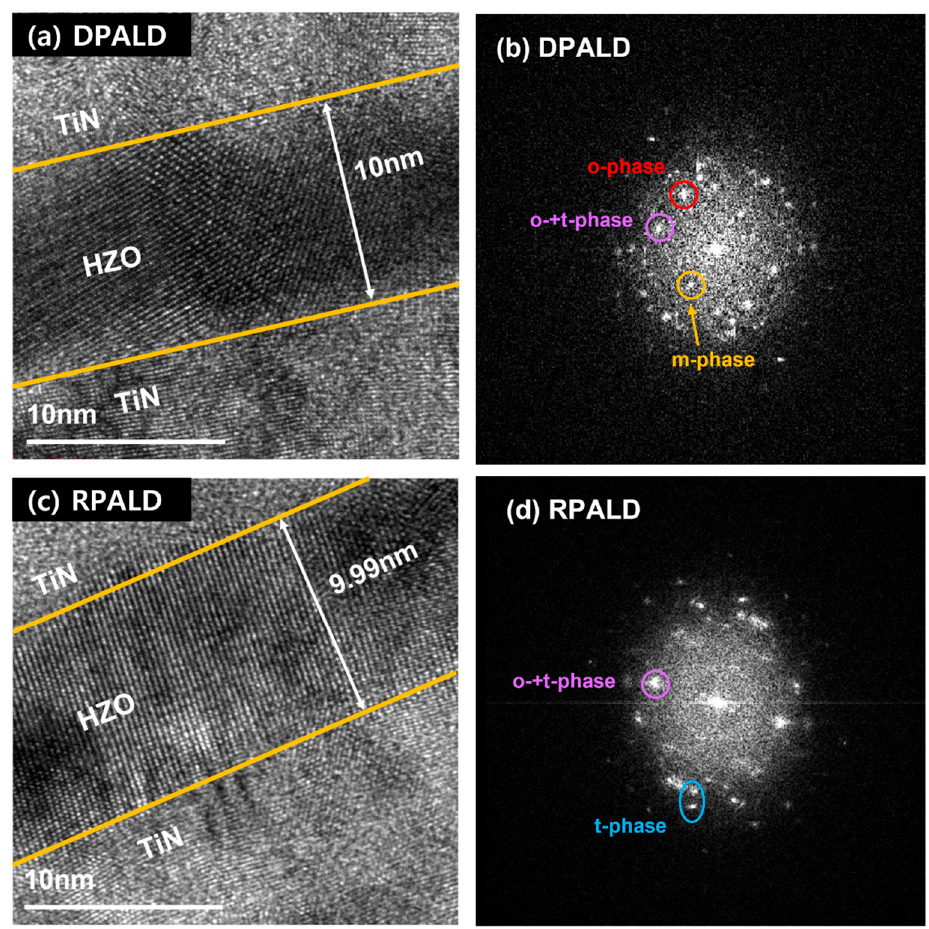
Figure 5. Cross-sectional TEM images and FFT patterns of HZO thin films deposited by ( a , b ) DPALD and ( c , d ) RPALD methods after heat treatment at 700 °C.